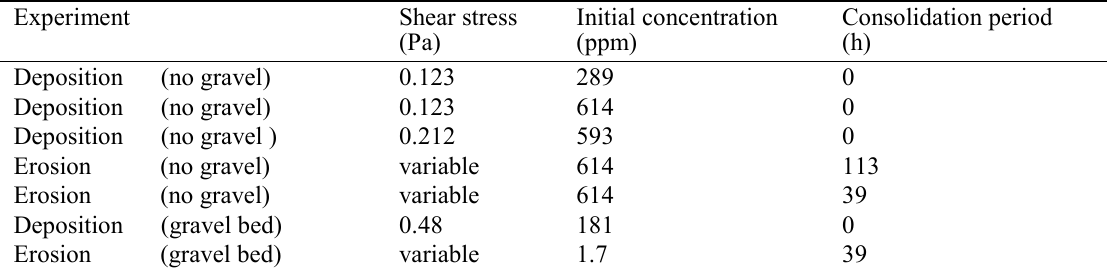
Table 1 Description of erosion and deposition experiments in the annular flume.